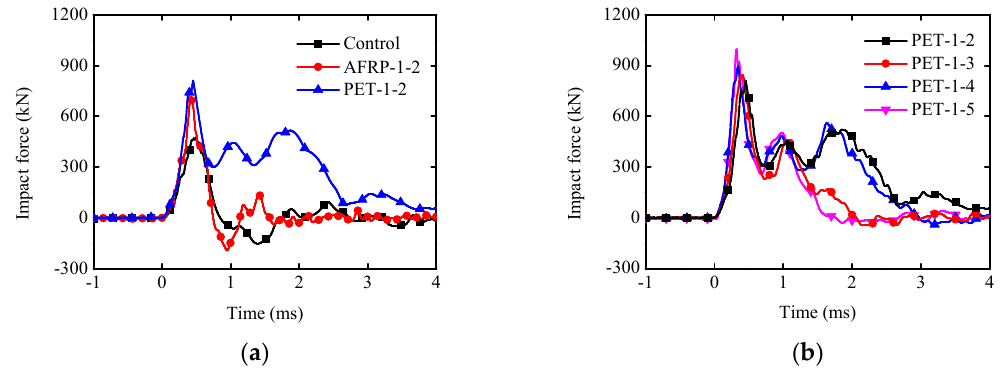
Figure 10. Impact force time histories of the FRP-confined concrete with different confining conditions ( a ) and different drop heights ( b ).